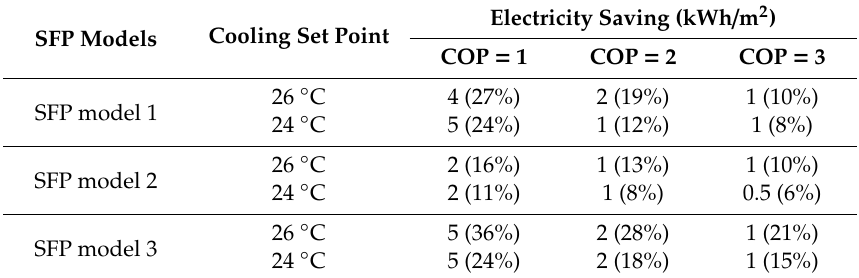
Table 13. The amount of saving in total electricity use for cooling during the hot summer of 2018 both in (kWh / m 2 ) and (%) as a result of applying NV strategy with the maximum beneficial NV rate (compared to the case without